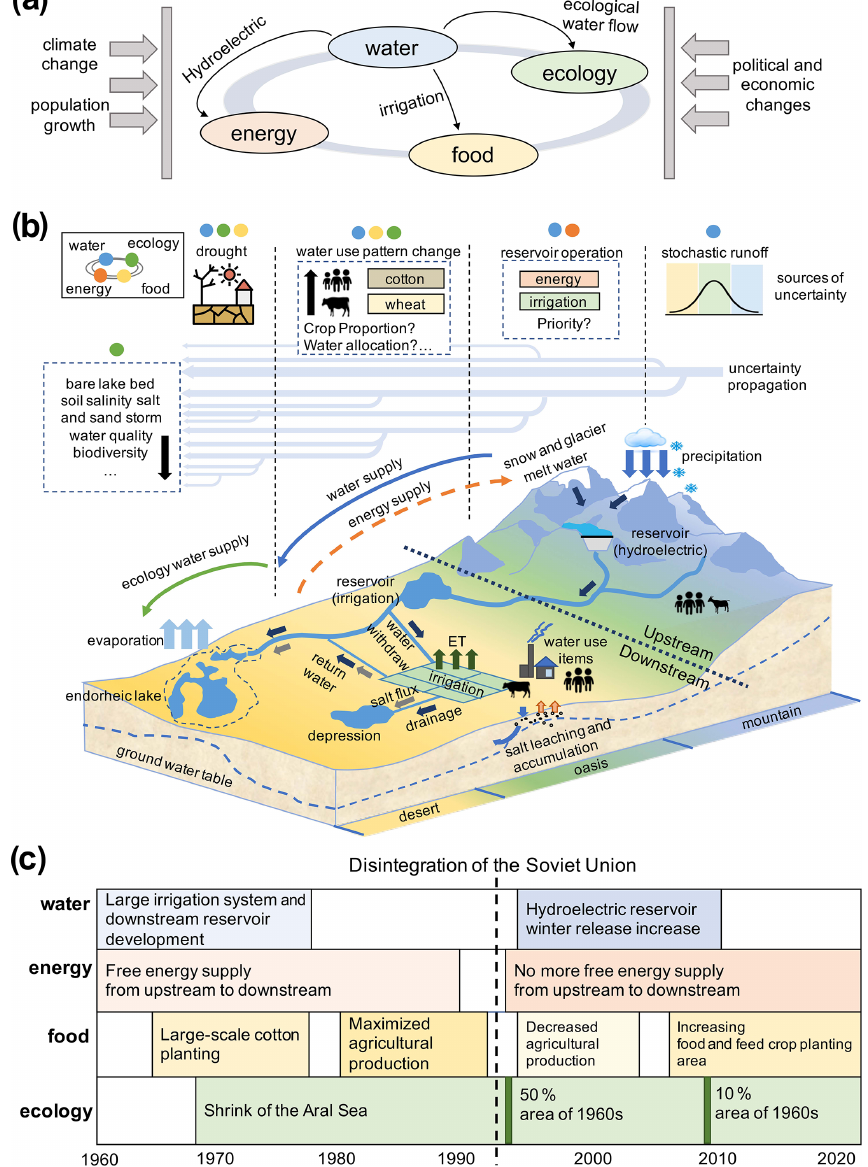
Figure 4. The a priori and general basin-wide WEFE nexus mode of the SDB and ADB and its temporal change during the past 50 years (a) shows the sources of the exogenous stress on the WEFE nexus dominated by water in the Aral Sea basin. Panel (b) illustrates the hydrologic uncertainty spread from the alpine area to the lower part through a typical “mountain–oasis–desert–lake” system. The elements of the WEFE nexus are represented by circles in four colours and the relevant uncertainty items are tagged with these icons as a classification by respective roles in the WEFE nexus. Panel (c) demonstrates the specific changes in the elements in the WEFE nexus during the past 50 years and the influence from the collapse of the USSR in